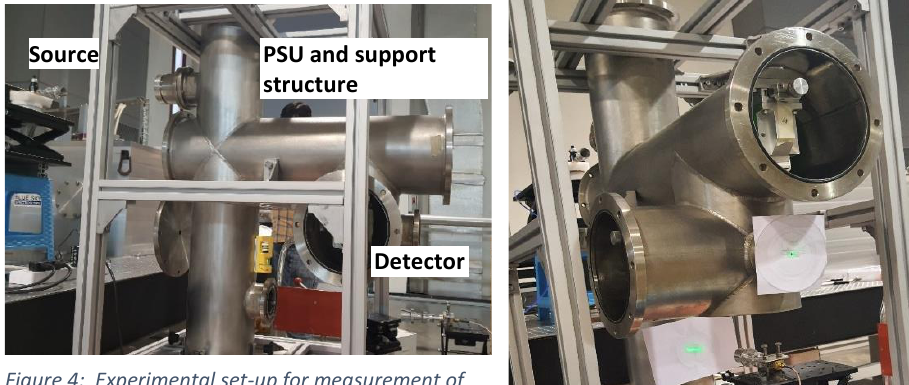
Figure 5: Well defined laser spot at both the output ports of PSU after alignment is done